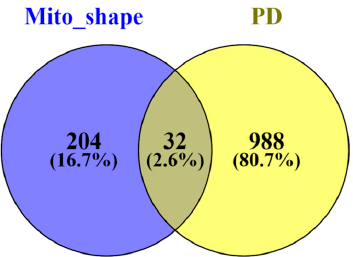
Figure 2. Venn diagram displaying the comparison of the number of the proteins found differentially